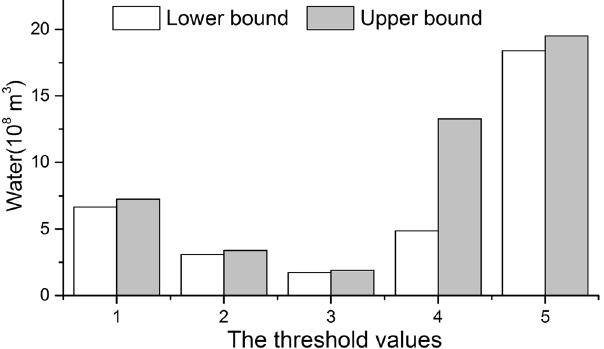
Figure 1. The saving and threshold of water rights transfer. Groups on the coordinate axis: 1 represent the threshold value of water saving from canal lining, 2 are from structural adjustment, and 3 are from drip irrigation, respectively; 4 represent the threshold values of best conditions for natural vegetation growth, and 5 are the values for desertification respectively.